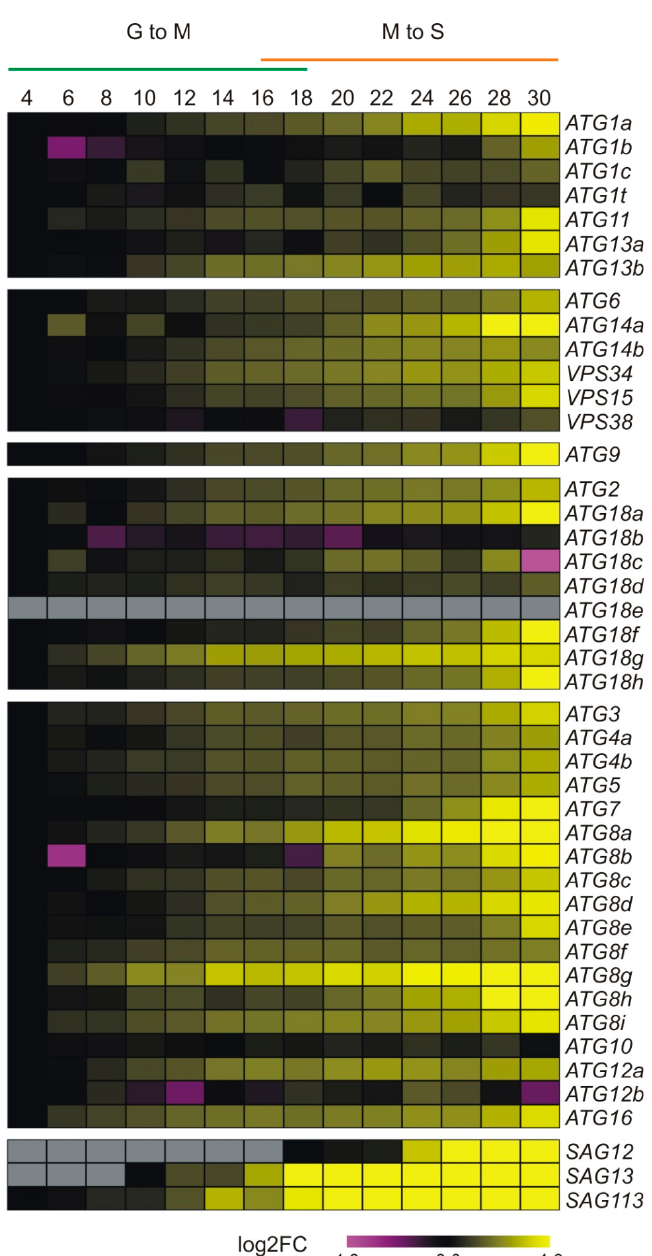
Figure 3. Expression pattern of ATG genes during leaf development. Data from a previous analysis (on the fourth rosette leaf at 2-day (d) intervals from 4 to 30 d after emergence from Arabidopsis ) were used [159]. The leaf lifespan was divided into two stages, growth-to-maturation (G-to-M) and maturation-to-senescence (M-to-S). Expression data are represented as a heatmap based on the log2FC change in Fragments Per Kilobase Million (FPKM) values compared to day 4 for each transcript. Next to the ATG genes, three SAG genes are also shown as representative markers for the onset of